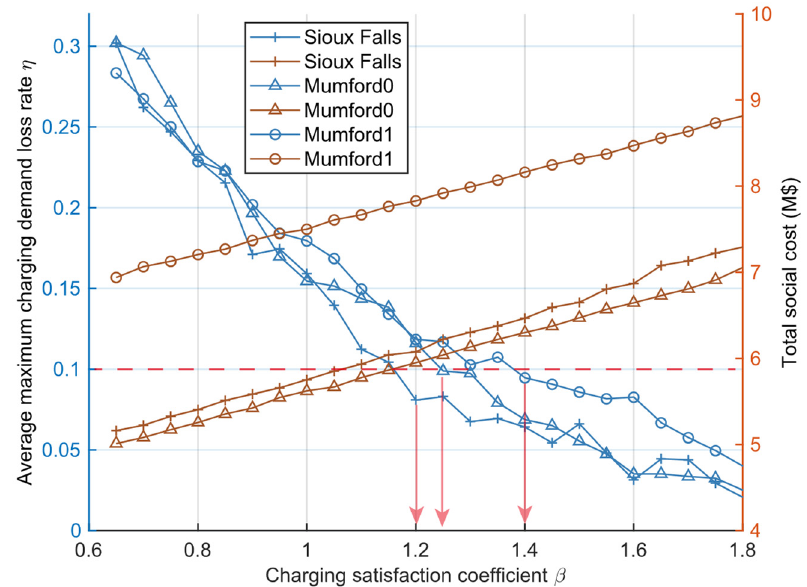
Figure 7. Optimal results with different charging satisfaction coefficient β . Maximum here stands for the maximum charging demand loss rate for a CS in different time intervals on a day, and average is for all CSs at all stages.